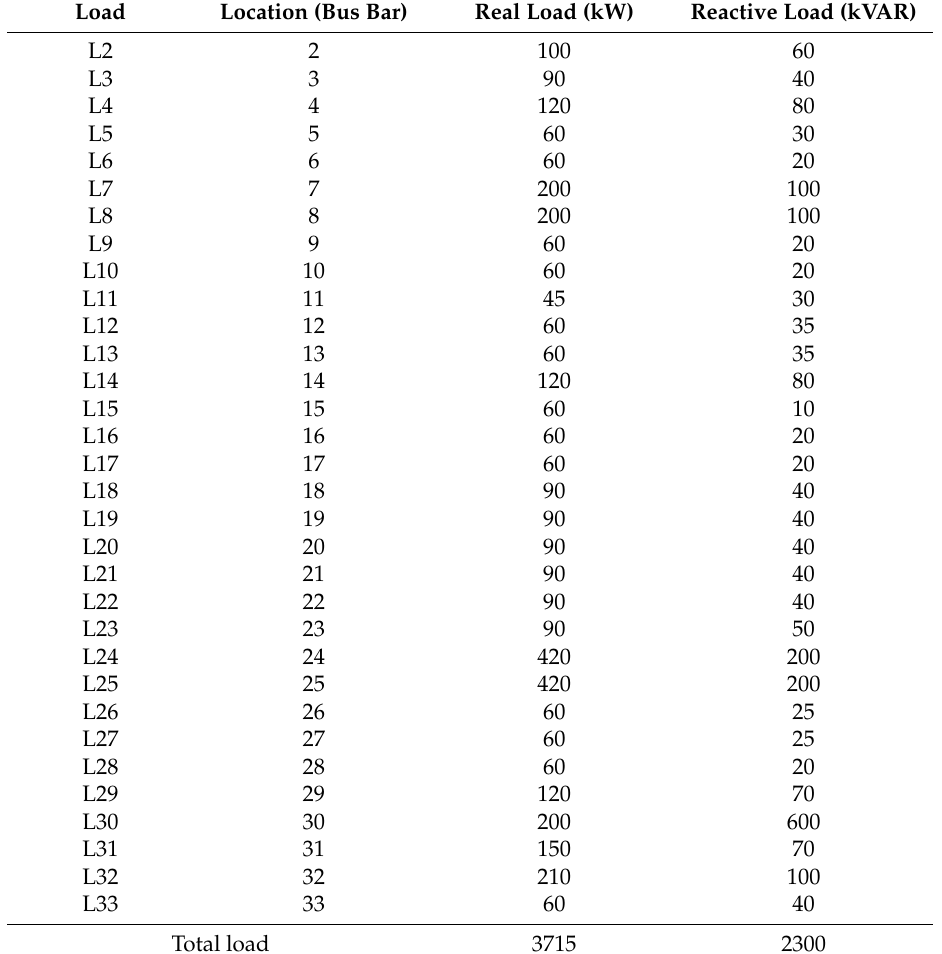
Table 2. Load data of the IEEE 33-bus radial distribution system